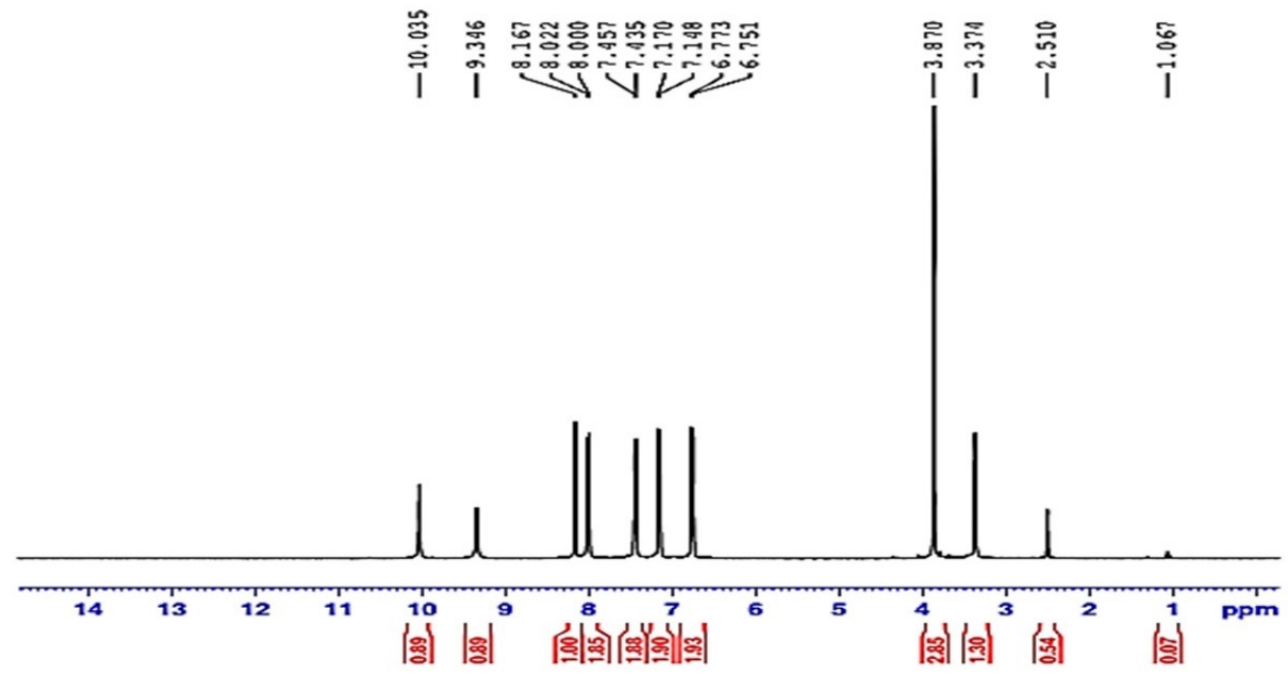
Figure 3. 1H-NMR spectrum of ACR-2.